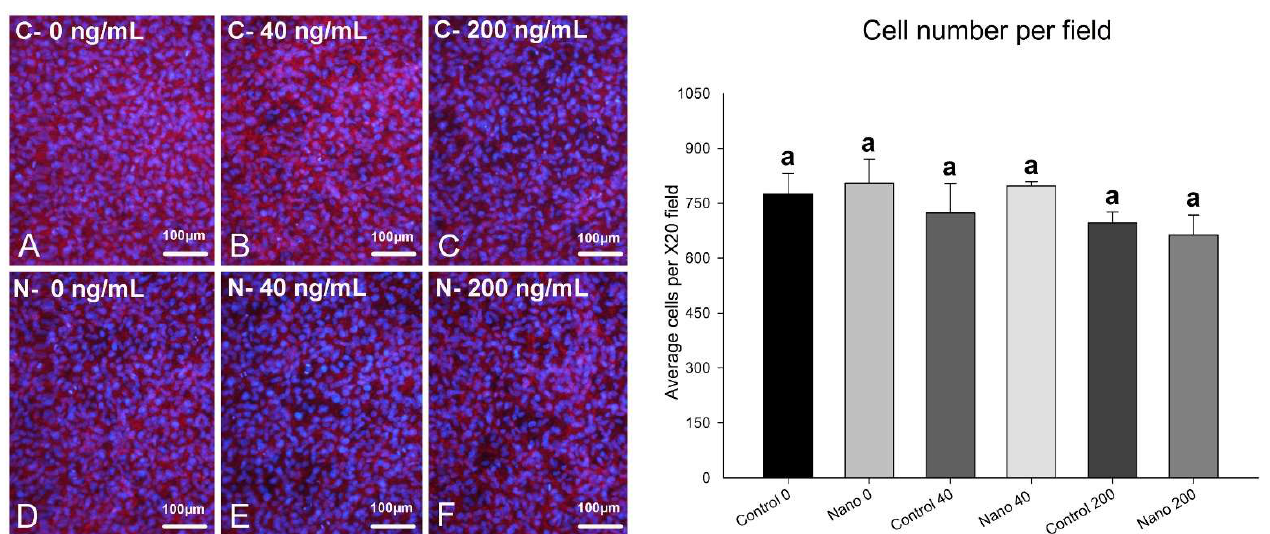
Figure 1. Epifluorescence imaging (left panel) and cell number per field (right panel) of MC3T3-E1 cells on day 5 of culture on Control-Ti ( A – C ) and Nano-Ti ( D – F ) exposed or not on days 2 and 4 of culture to 40 and 200 ng/mL BMP-7 in the culture medium. ( A – F ) Red fluorescence (Alexa Fluor 594 phalloidin) reveals an actin cytoskeleton, and cell nuclei stained with DAPI appear with blue fluorescence. All bars share the same letter and are not significantly different from each other ( p > 0.05).